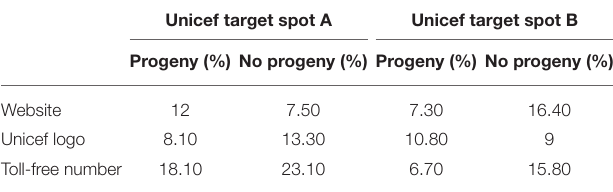
TABLE 1 | Time spent (%) among three different areas of interest in Unicef spots. Unicef target spot A